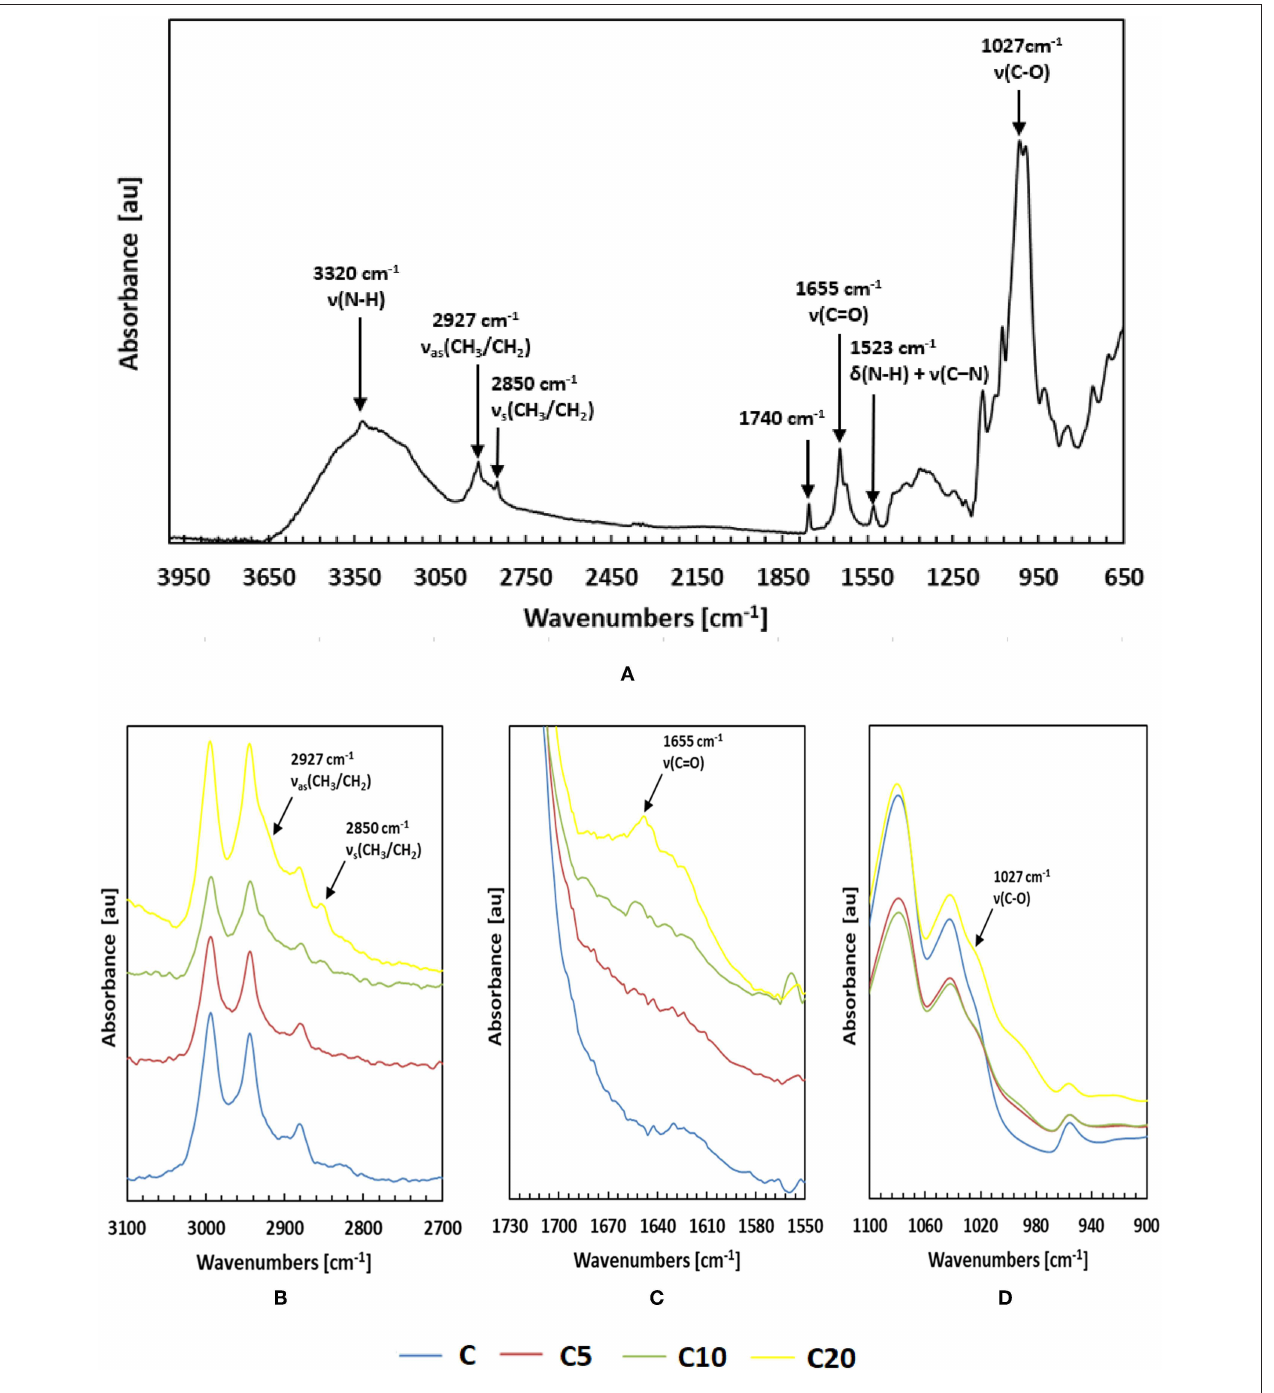
FIGURE 1 | ATR-FTIR spectra of LAE (A) and of the thin PLA coating layers C, C5, C10, and C20, loaded at 0, 5, 10, and 20% LAE, respectively (B–D) .